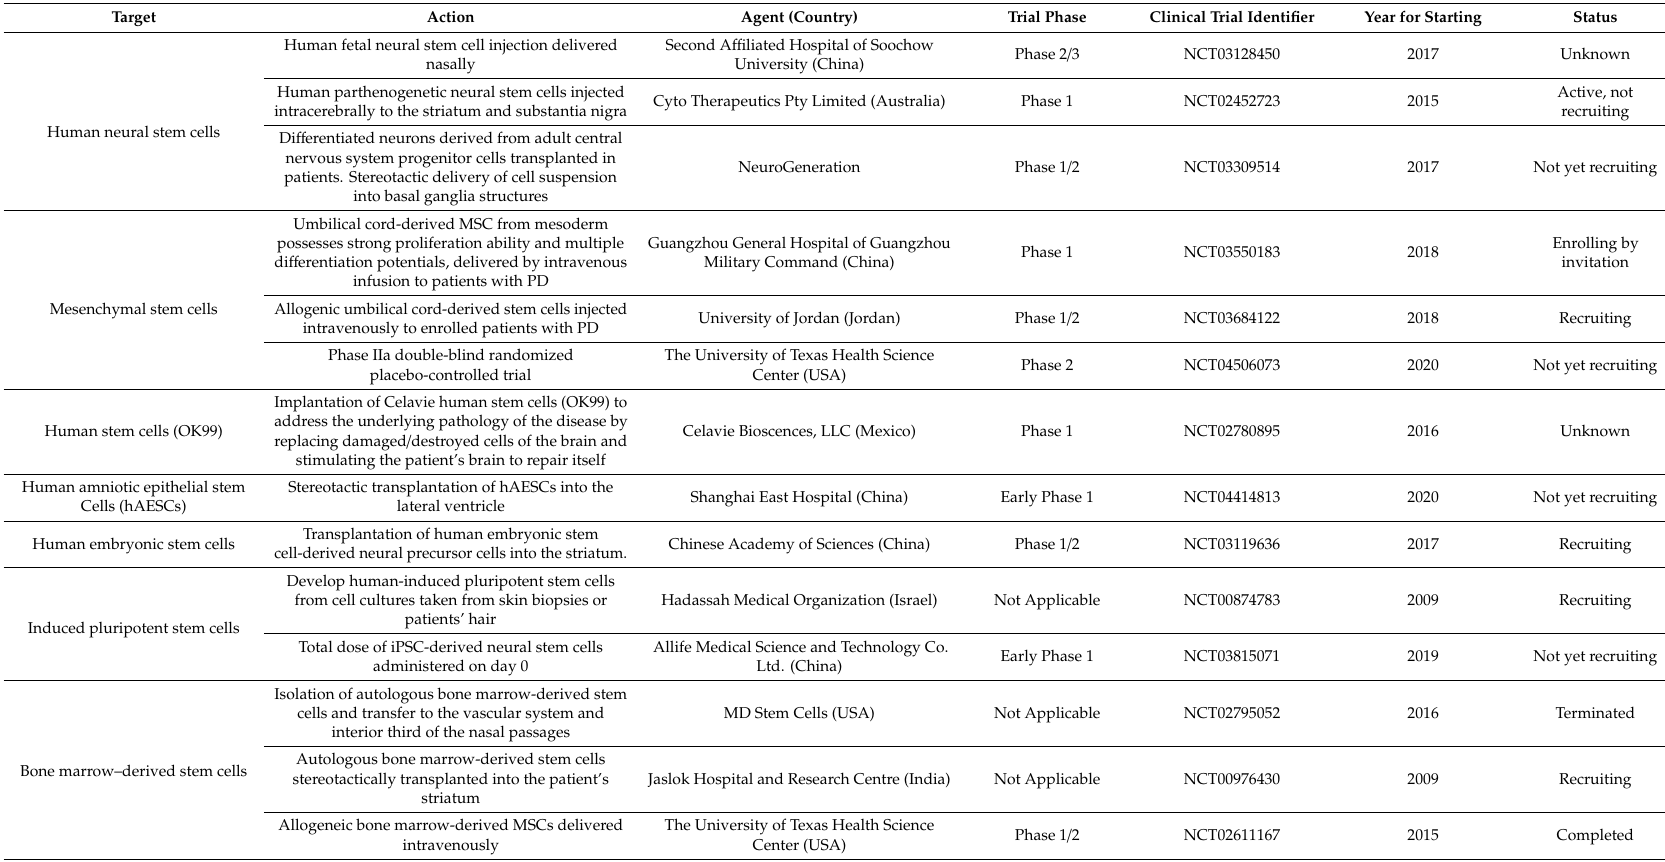
Table 1. Clinical trials using stem cells as treatments for